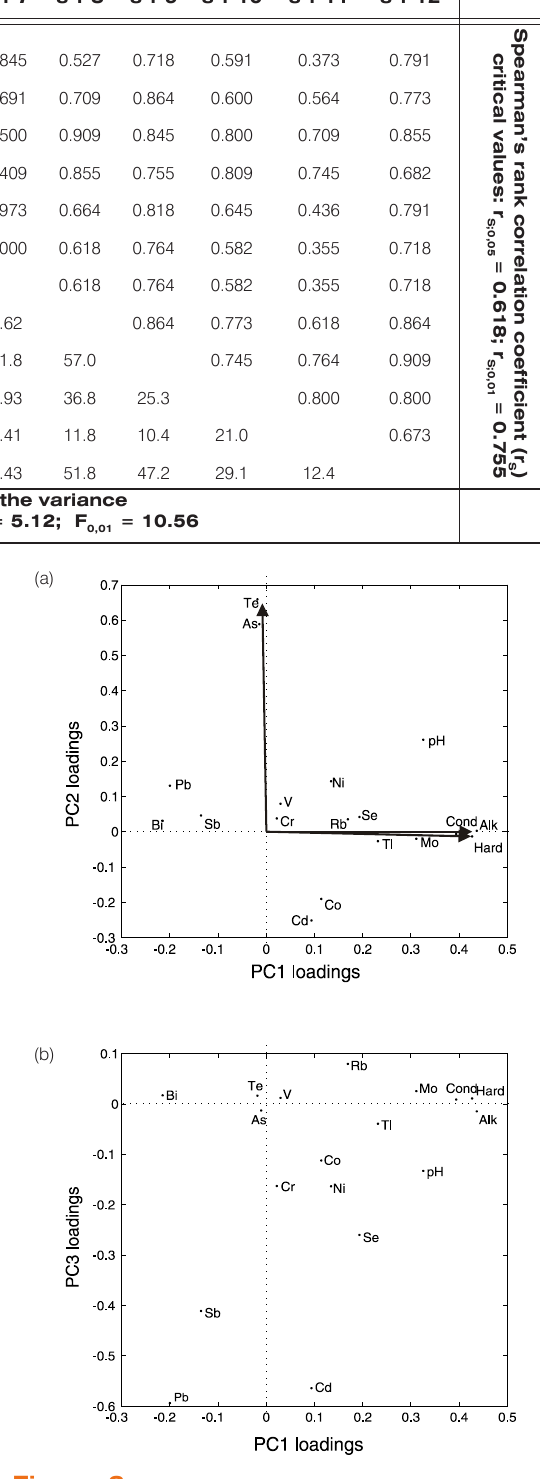
Figure 3. Loading plots - parameters on the plane spanned by: (a) PC 1 and PC 2, (b) PC 1 and